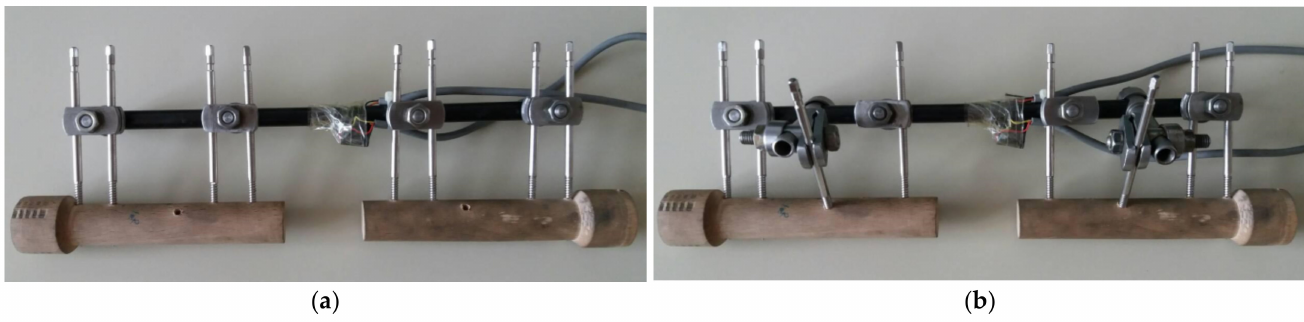
Figure 2. Sarafix fixation device with composite frame; ( a ) B50 configuration, ( b ) C50 configuration.